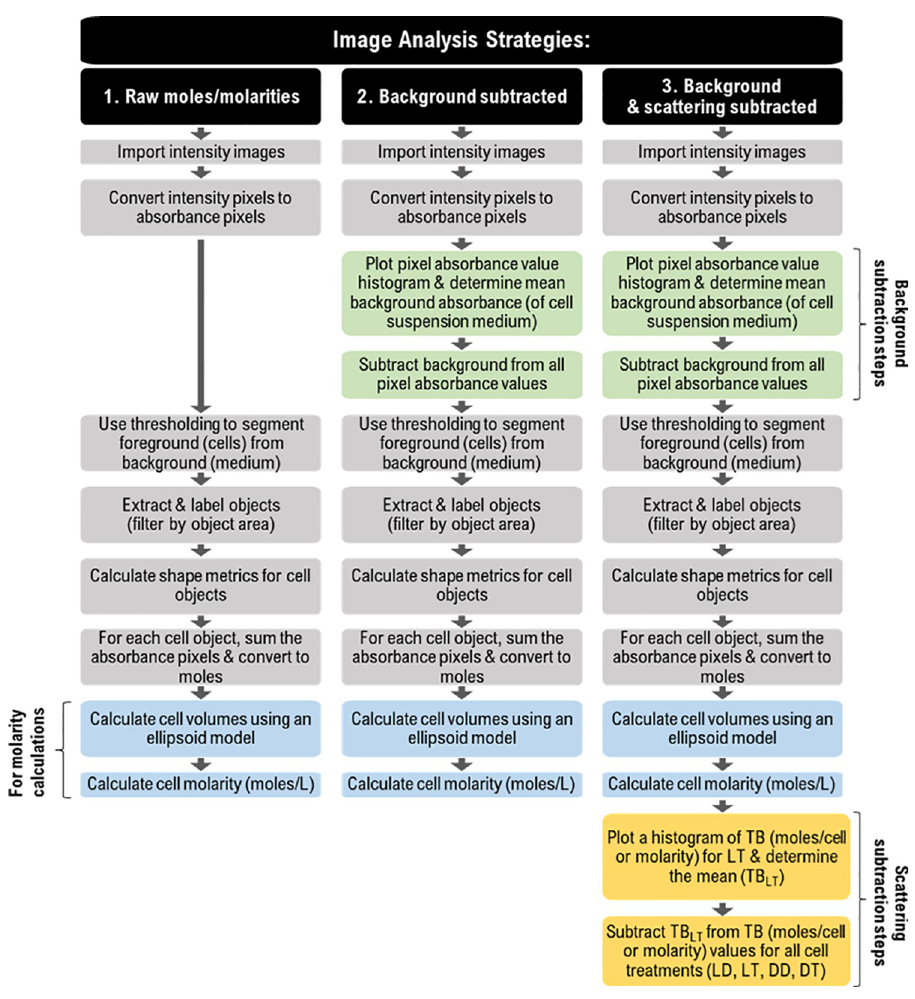
Fig 1. Flow chart outlining three strategies of the image analysis workflow. As the complexity of the image analysis workflow increases, so does the accuracy of the intracellular content of trypan blue (TB) calculation. Abbreviations: LD = live cells in Dulbecco’s phosphate-buffered saline (DPBS) solution, LT = live cells in TB solution mixed with DPBS at a 1:4 (TB:DPBS) ratio, DD = dead cells in DPBS, DT = dead cells in TB solution mixed with DPBS at a 1:4 ratio (TB:DPBS) and TB LT = TB content in LT